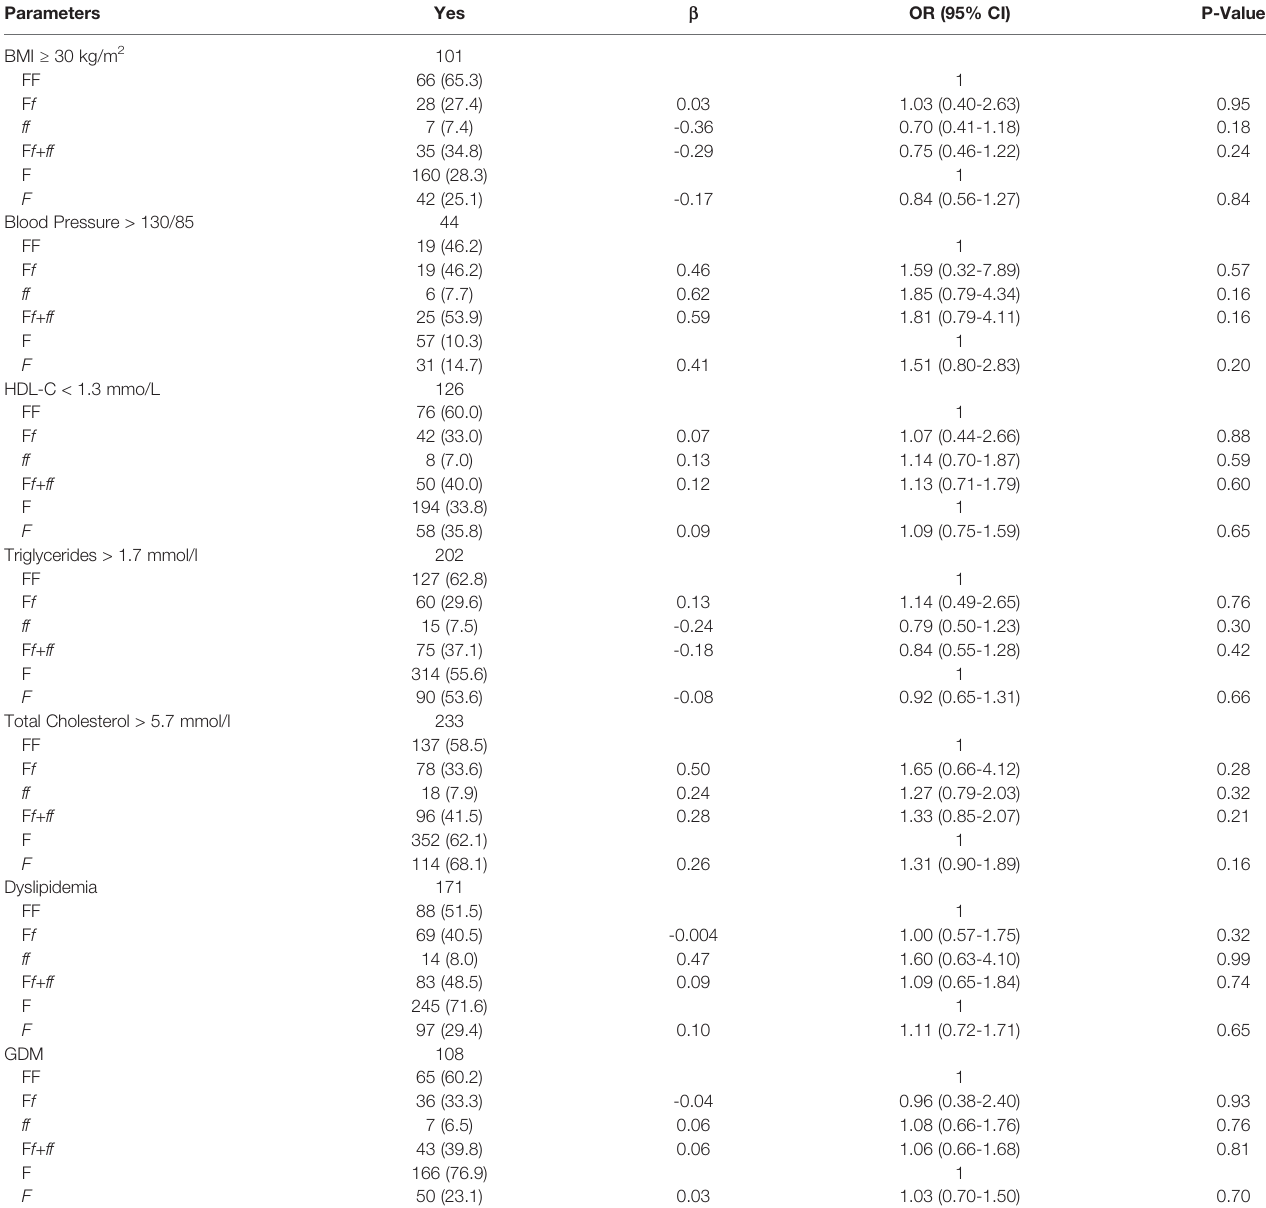
TABLE 4 | Risk of the FokI VDR gene polymorphisms with MetS and its components. Parameters Yes b